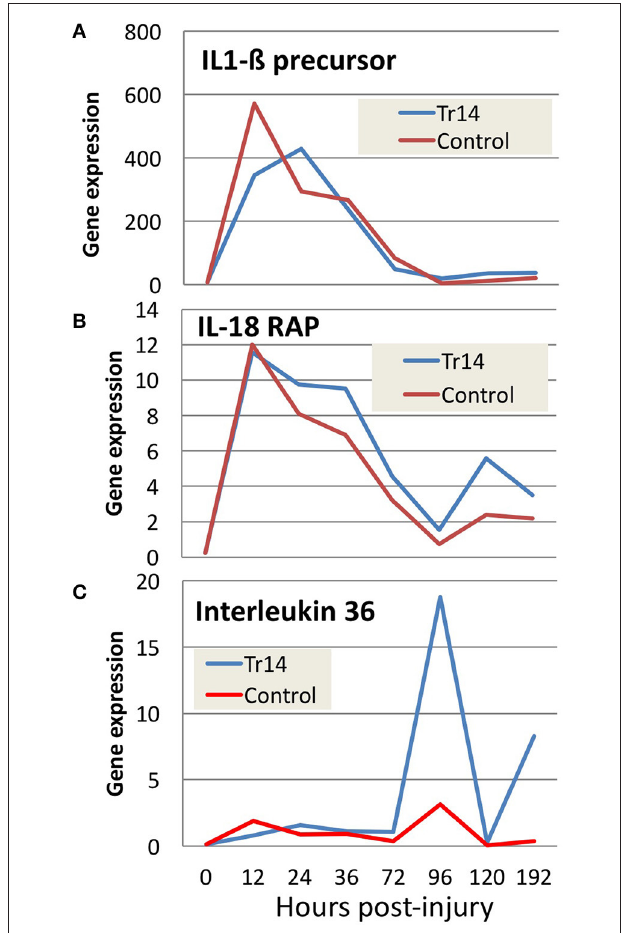
FIGURE 4 | The effect of Tr14 on select transcripts in the interleukin pathway. RNA sequencing data was analyzed to identify transcripts modulated by Tr14 treatment. Significant increases in three of the transcripts (A–C) in the interleukin pathway are shown as gene expression (RPKM, Y axis) as a function of time in hours (X